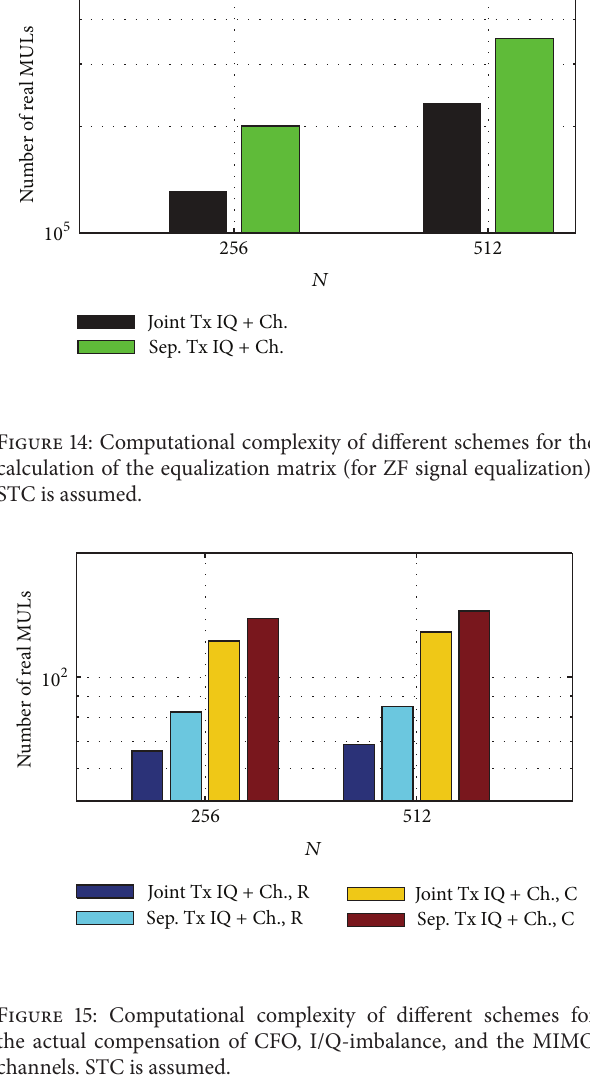
Figure 15: Computational complexity of different schemes for the actual compensation of CFO, I/Q-imbalance, and the MIMO channels. STC is